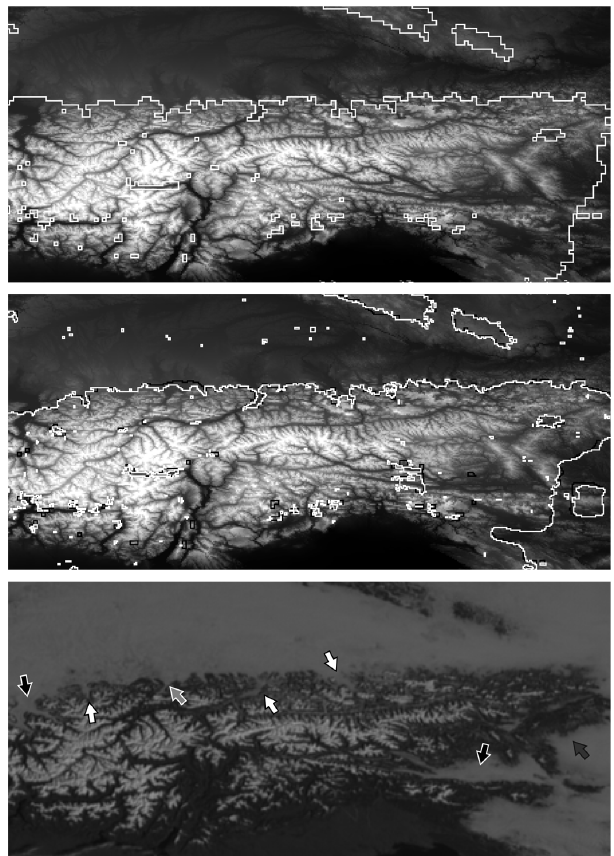
Fig. 11. 3km (top) and 1km (center) FLS masks (indicated by the white outline) for fog north of the Alps on 2 February 2011. The masks’ outlines are underlaid by a DEM. White line = boundary of the 3km and 1km masks. Black line = boundary of an additional FLS mask based on channels interpolated to 1km resolution. White arrows = details that strongly benefit from the resolution enhance- ment. Black arrows = Areas that were not identified as FLS regard- less of the resolution. Light grey arrow = an area that was only de- tected as FLS in 3km resolution. Dark grey arrow = an area that was only detected as FLS in 1km resolution.